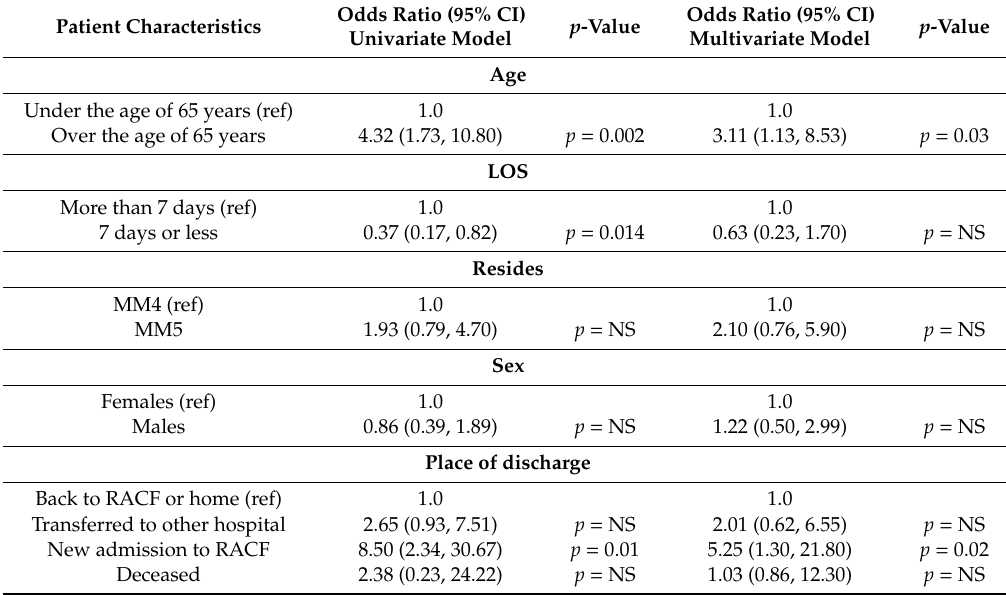
Table 4. Odds of malnutrition diagnosis by dietitians according to demographic factors (univariate and multivariate models).